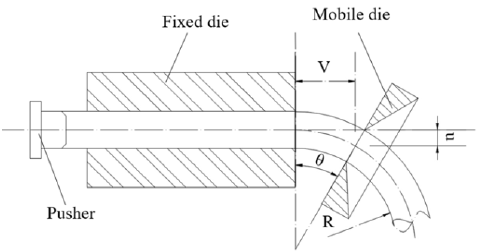
Table 1. Bending parameters of pipe.